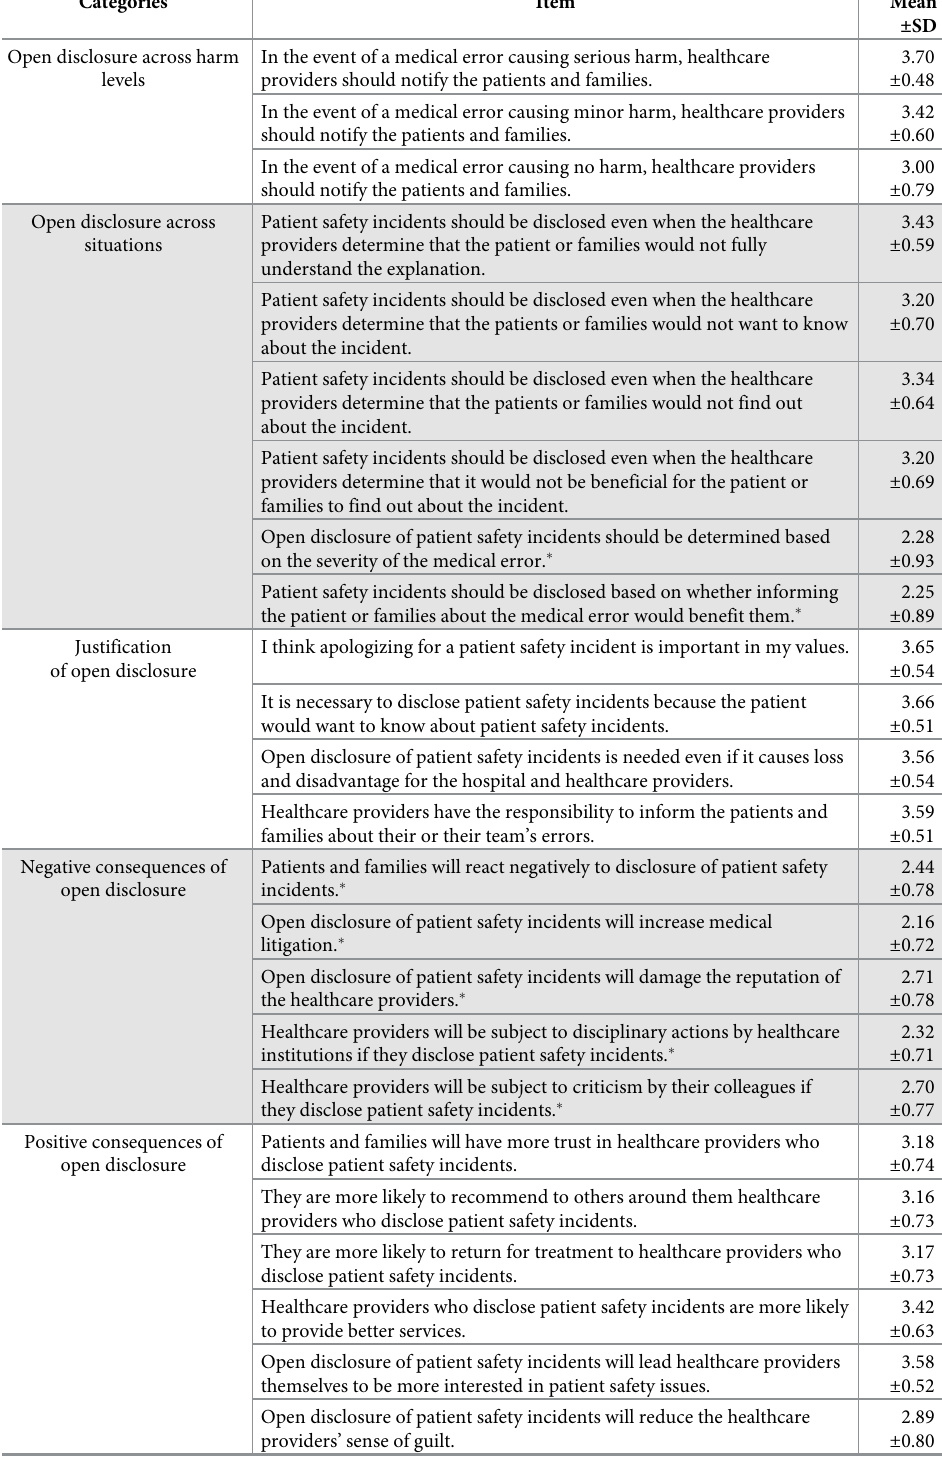
Table 2. Perceptions of disclosure of patient safety